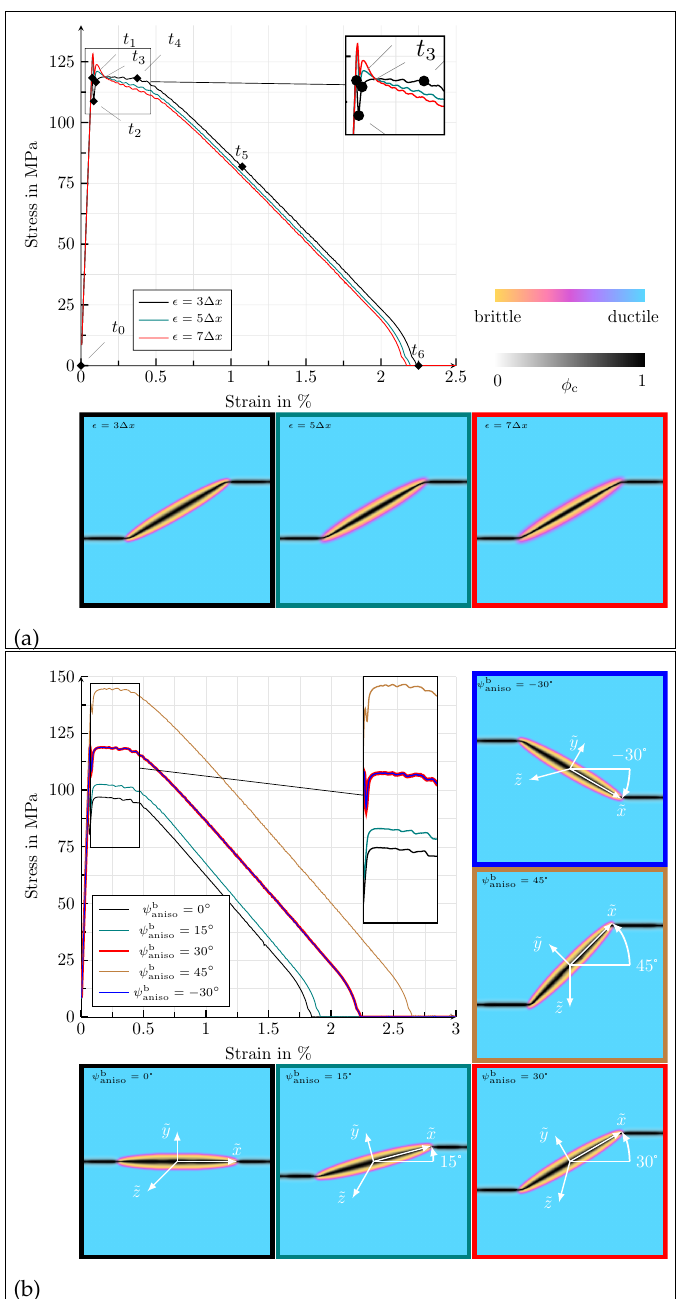
Figure 6. ( a ) Homogenised macroscopic stress–strain responses in the case of uniaxial tension ∆ x , for the simulation setup with a single elliptic, transversely for different values of (cid:101) = 3,5,7 { } isotropic, brittle inclusion in a ductile matrix. The dots in the stress–strain diagram correspond to the strain states of the contour plots of Figure 7. Below the diagram, contour plots of the crack phase φ c at fracture are given, overlaying the solid phases for the various values of (cid:101) . ( b ) Homogenised macroscopic stress–strain responses in the case of uniaxial tension for different values of ψ b 0,15,30,45, 30 °, for the simulation setup with a single elliptic, transversely isotropic, brittle { − } inclusion in a ductile matrix. The contour plots of the crack phase φ c at fracture, overlaying the solid phases, for the different values of ψ b are given below and beneath the stress–strain aniso